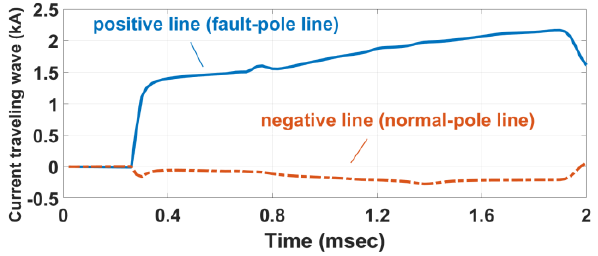
Figure 5. Diagram of the line coupling effect.